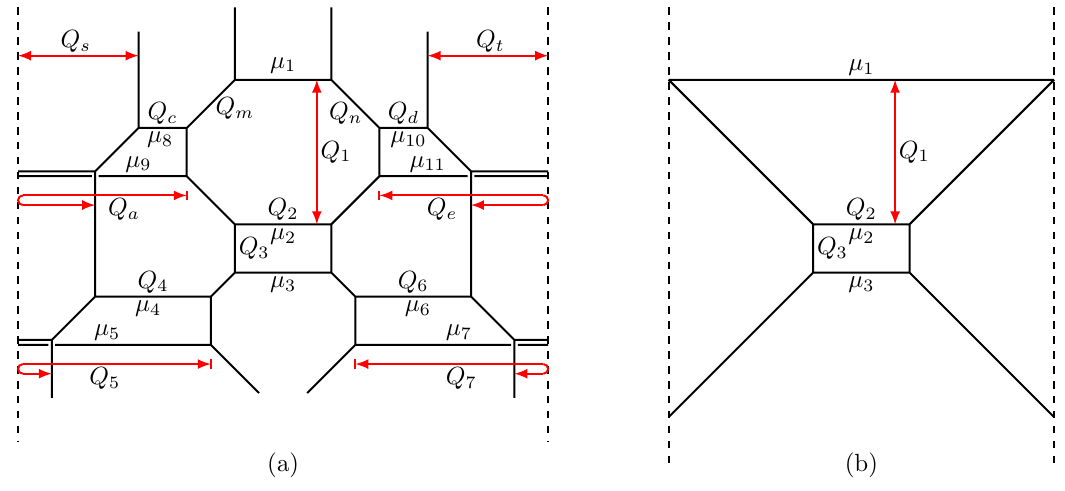
Figure 18 . (a) A 5-brane web for the affine D 4 -type quiver with two ON-planes on the left and right. (b) SU(3) with CS 9 obtained by Higgsing and